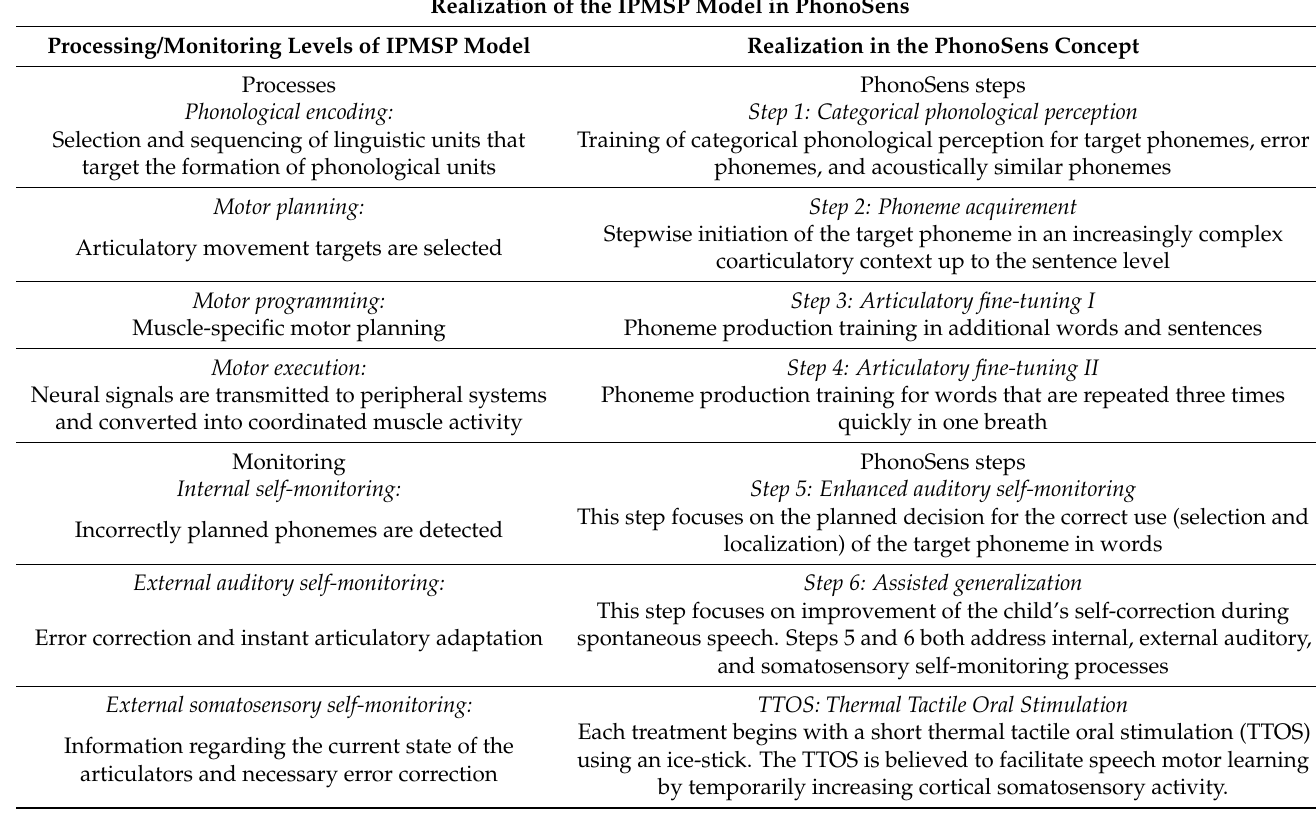
Table 1. Processing and monitoring levels involved in the speech production chain according to the IPMSP model by Terband et al. [23] and the corresponding steps of the PhonoSens treatment concept. Realization of the IPMSP Model in PhonoSens Processing/Monitoring Levels of IPMSP